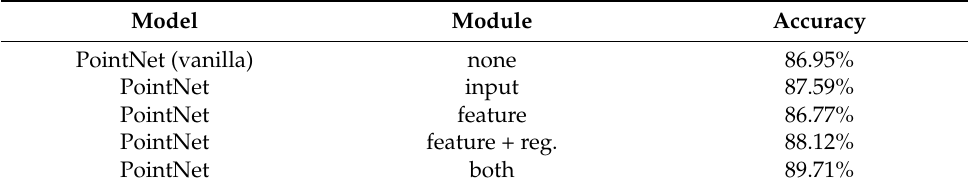
Table 1. Effect of T-Net network on model accuracy.